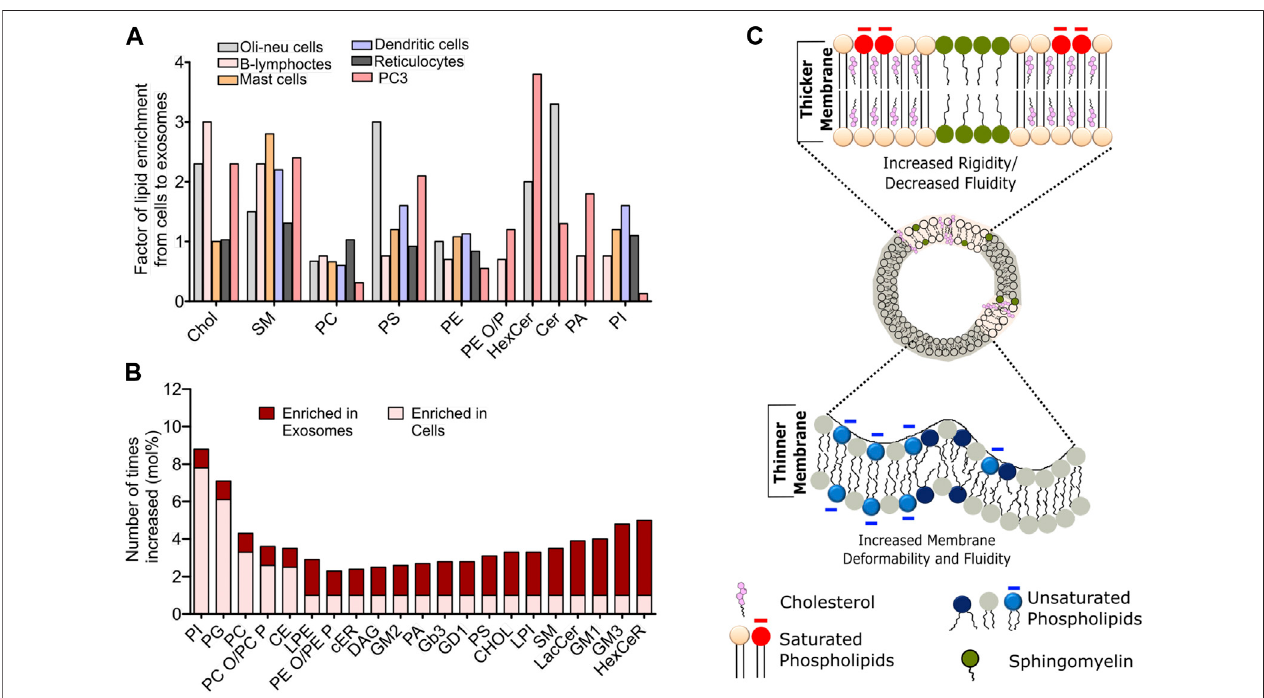
FIGURE 2 | Compositional heterogeneity in membrane vesicles guide their membrane biophysical properties. (A) Fold change in the abundance of speci fi c lipid species in exosomes compared to the donor cells across various cell lines. Data reprinted from Biochimica et Biophysica Acta (BBA) - Molecular and Cell Biology of Lipids, Llorente, A et al. Molecular lipidomics of exosomes released by PC-3 prostate cancer cells, 2013, 1831, 1,302 – 1,309. Copyright (2013), with permission from Elsevier (B) Relative changes in the abundance of indicated lipid constituents in the exosomes derived from PC3 cells. The data has been adapted with from Skotland et al. (2019) (C) . Schematic representation of biophysical attributes such as rigidity, membrane thickness and fl uidity of cell-derived membrane vesicles dependent on the lipid composition. Enrichment of cholesterol and saturated lipid confer high rigidity and higher membrane thickness, while enrichment of unsaturated lipids leads to increased fl uidity and higher membrane